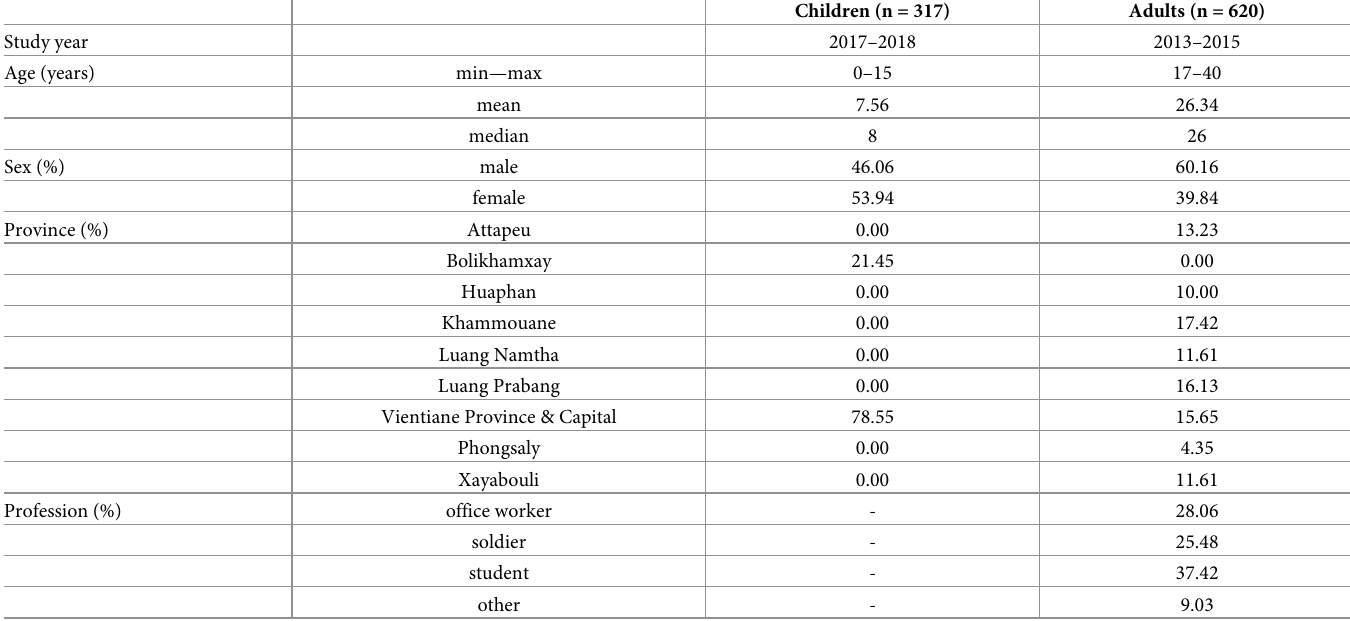
Table 1. Characteristics of study participants in adult and child